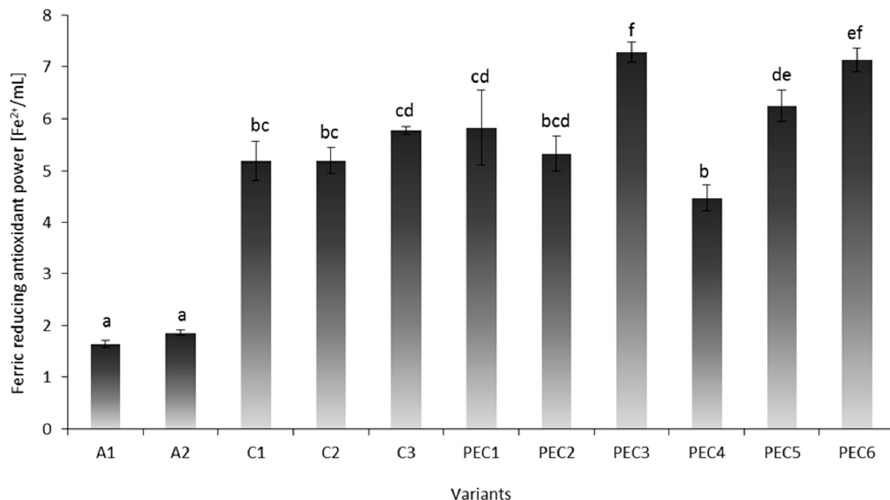
Figure 2. The antioxidant activity of sodium alginate (A1, A2), chitosan (C1, C2, C3), and polyelectrolyte complex (PEC1–PEC6) hydrosols determined by ferric reducing antioxidant power (FRAP). Values with different letters (a–f) differ significantly ( p < 0.05), n = 3.